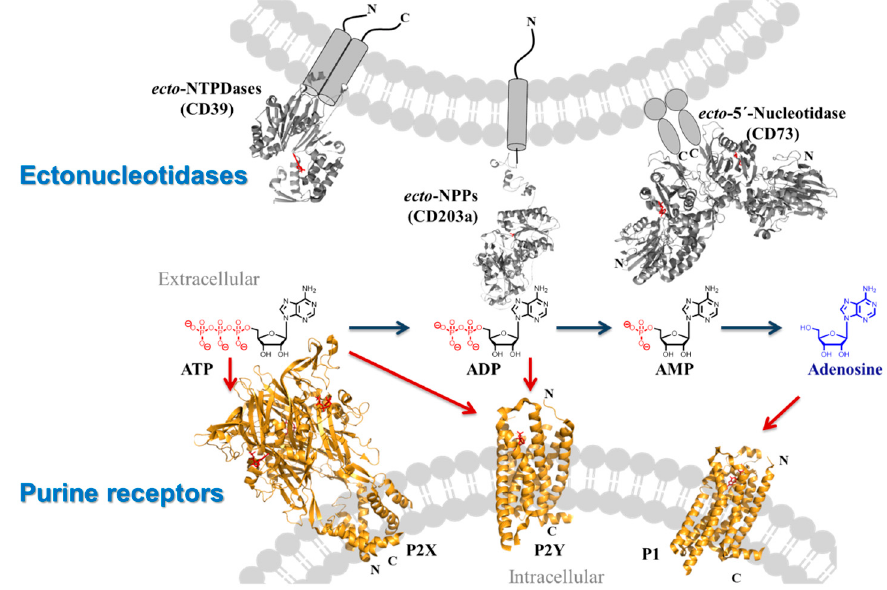
Figure 3. Activation pathway of purine P2Y and P2X receptors.